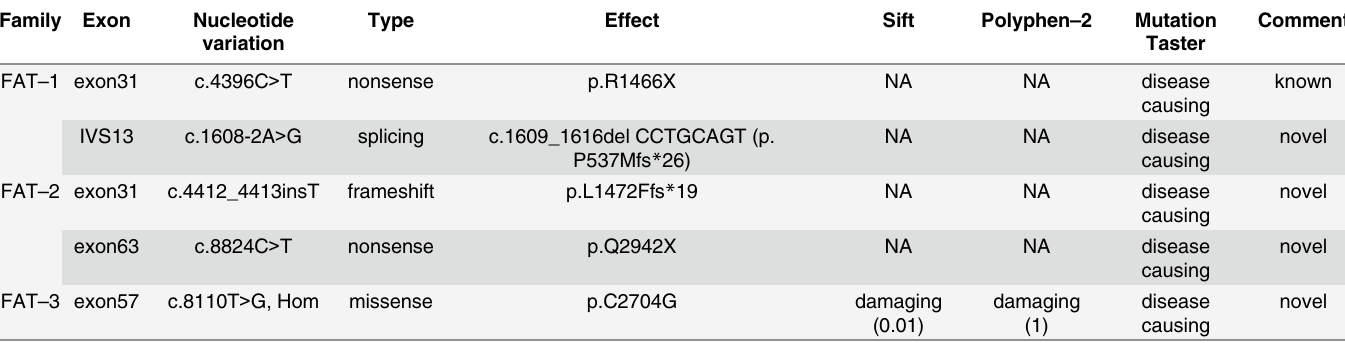
Table 3. Summary of putative pathogenic mutations validated via Sanger sequencing or RT-PCR. Family